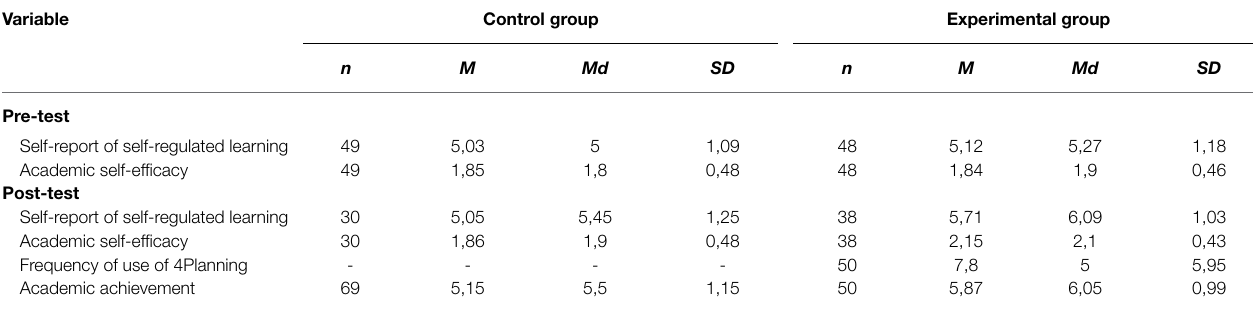
TABLE 2 | Descriptive data of the study variables in the control group and in the experimental group. Variable